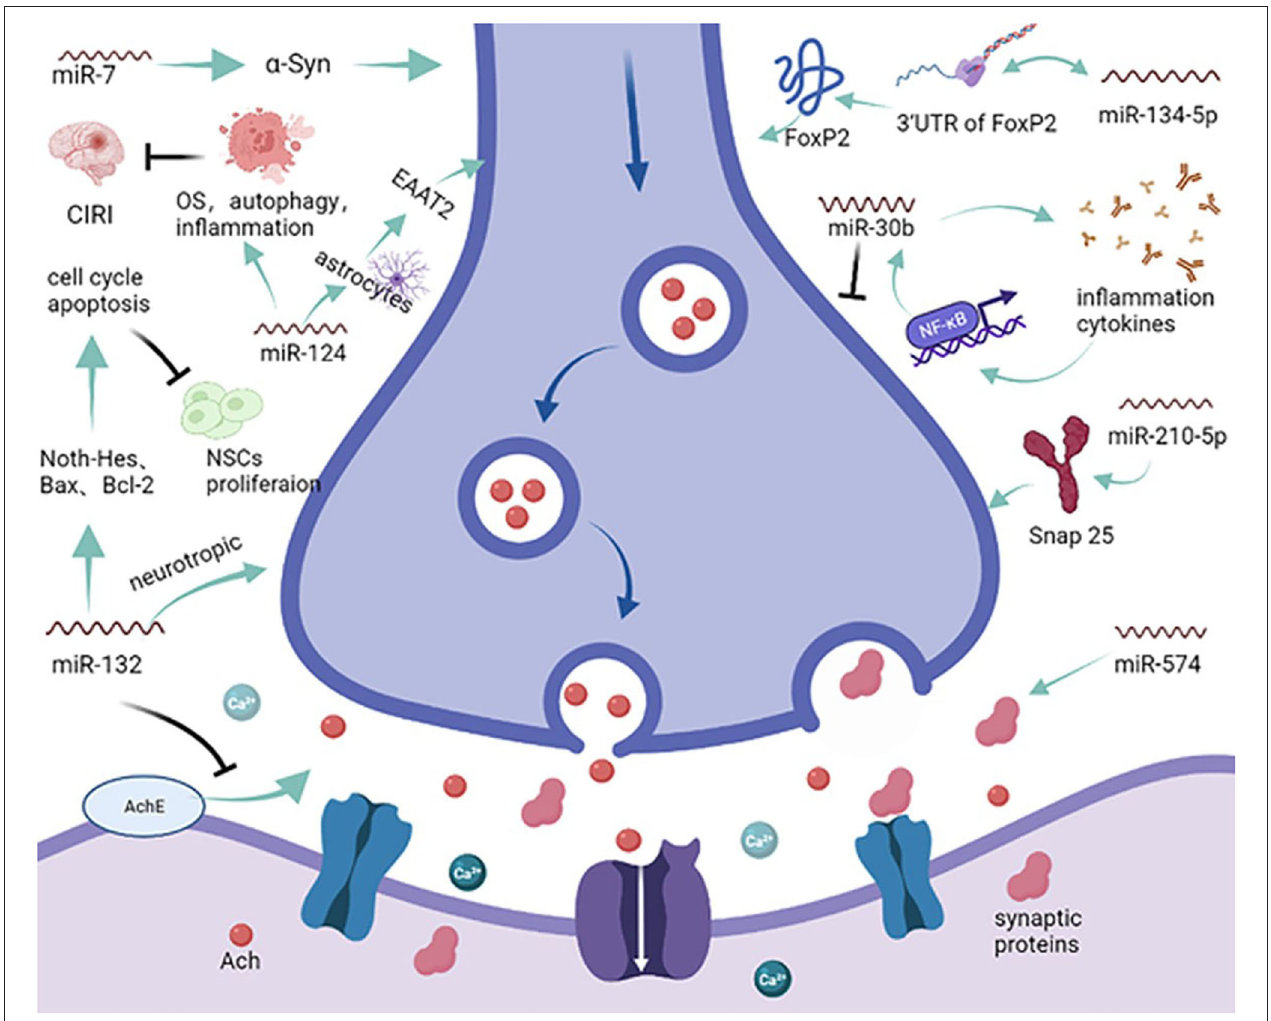
FIGURE 2 | miRNAs and the synapse. MicroRNAs enveloped in exosomes can be released to target acetylcholine (Ach) and synaptic proteins, affecting the transmission of information at the synapse. miR-124 can modulate synaptic activation via the excitatory amino acid transporter 2 (EAAT2) and dysregulate oxidative stress autophagy to reduce cerebral ischemia reperfusion injury. Furthermore, miR-132 can modulate the degradation of Ach and dysregulate the proliferation of neural stem cells. On the other hand, miRNAs can also modulate synaptic neurodifferentiation via Snap 25, FxP2, and many other inflammatory